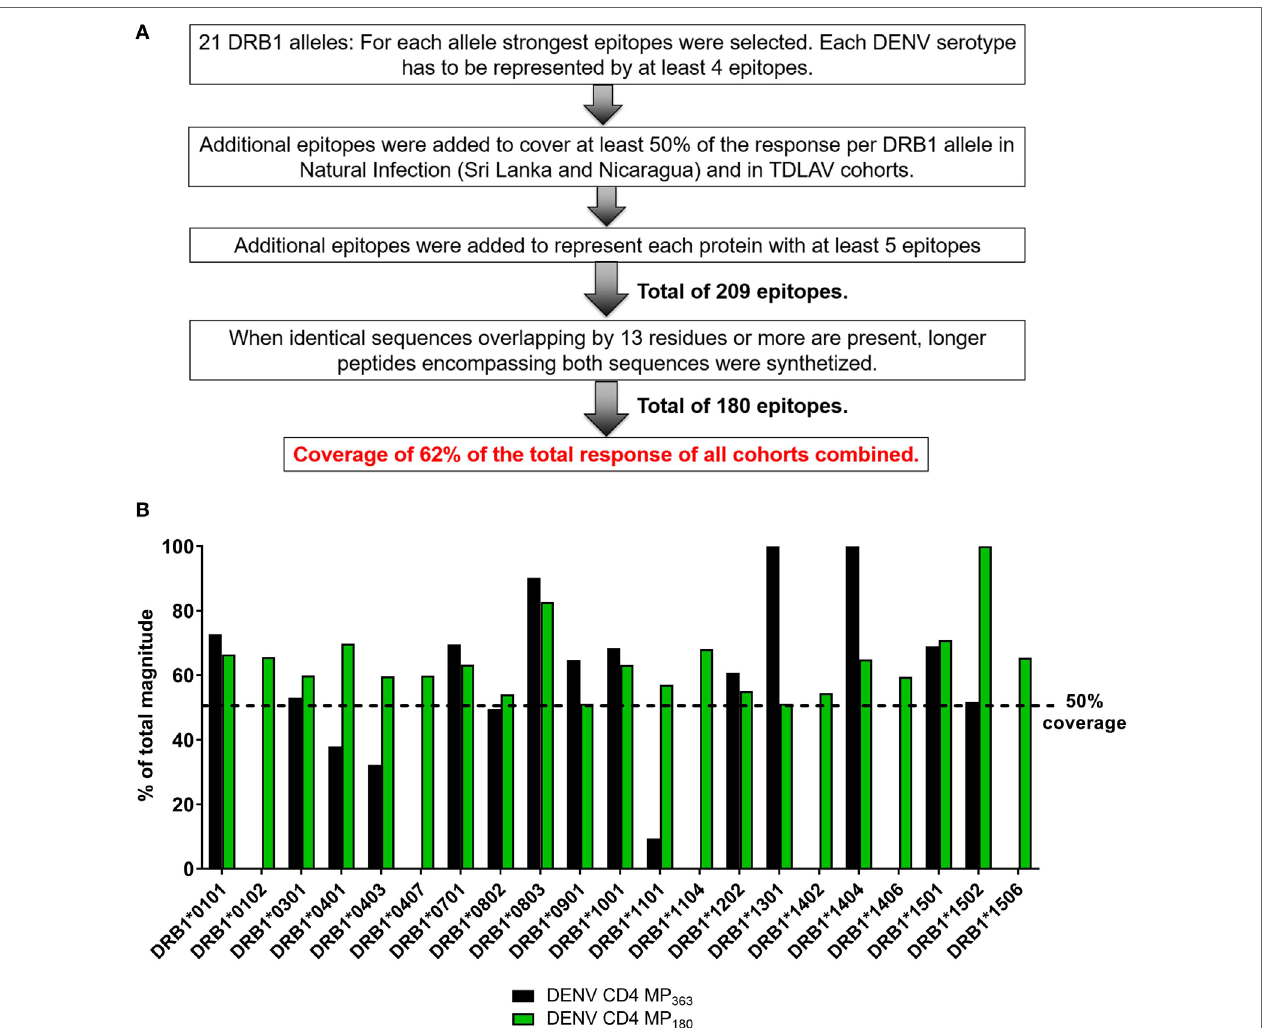
FigUre 4 | Characteristics of dengue virus (DENV) CD4 MP 180 . (a) Strategy used to select the epitopes composing the DENV CD4 MP 180 . (B) Comparison of HLA coverage in terms of magnitude of responses for epitopes belonging to the two DENV CD4